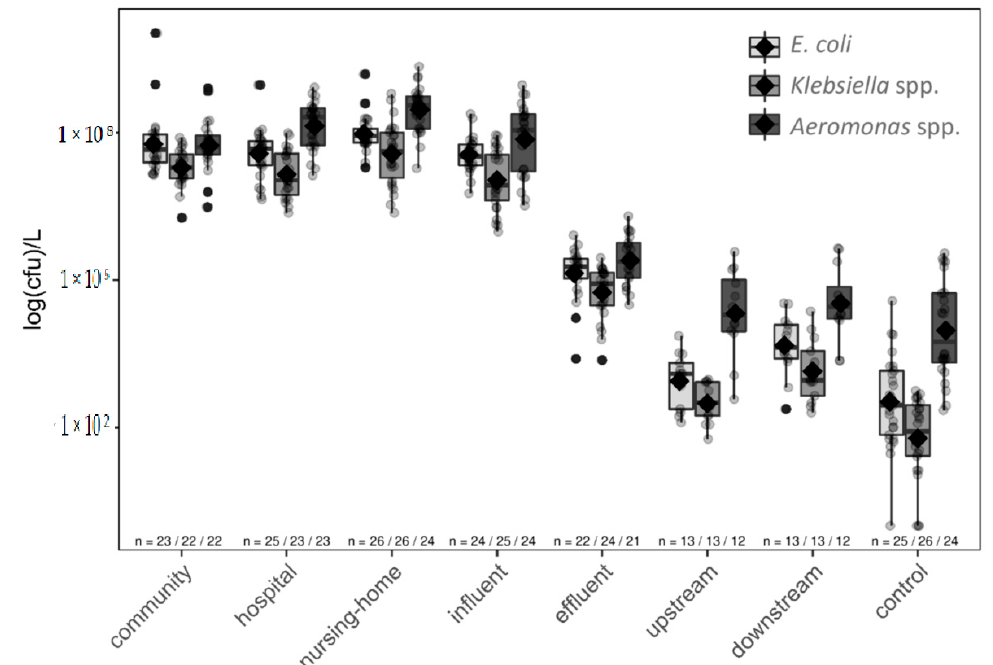
Figure 4. The counts of colony forming units (CFU) for the three targeted bacteria per location. The bacterial counts are shown as log (CFU) / L, n is the number of collected samples used for the CFU counts. The diamonds within the boxplots represent the mean, the distribution of the CFU counts are shown as scatterplots.